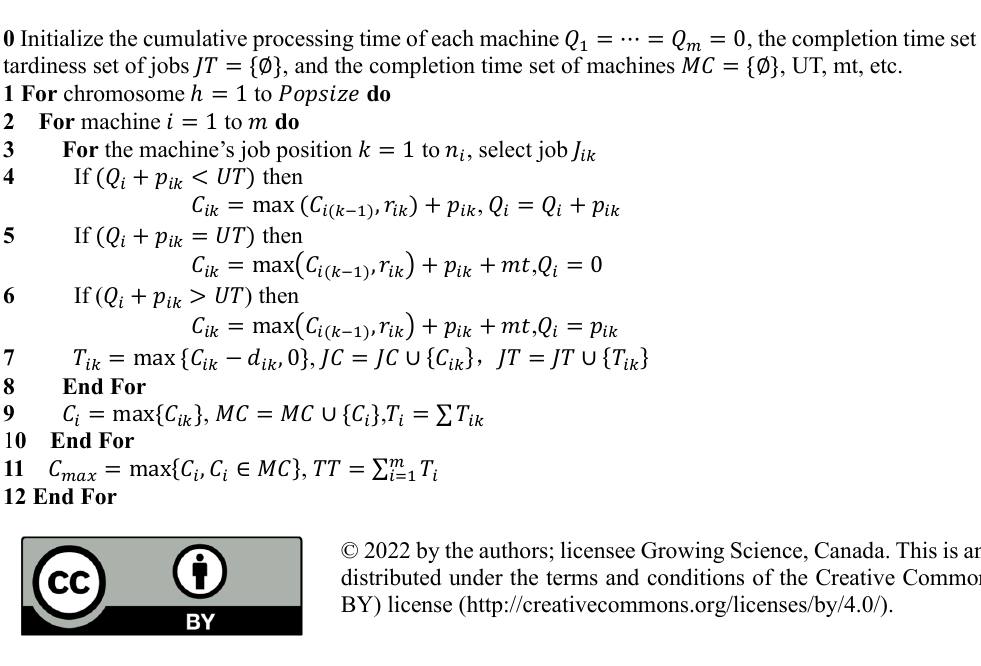
Algorithm 3 ： Full loading decoding